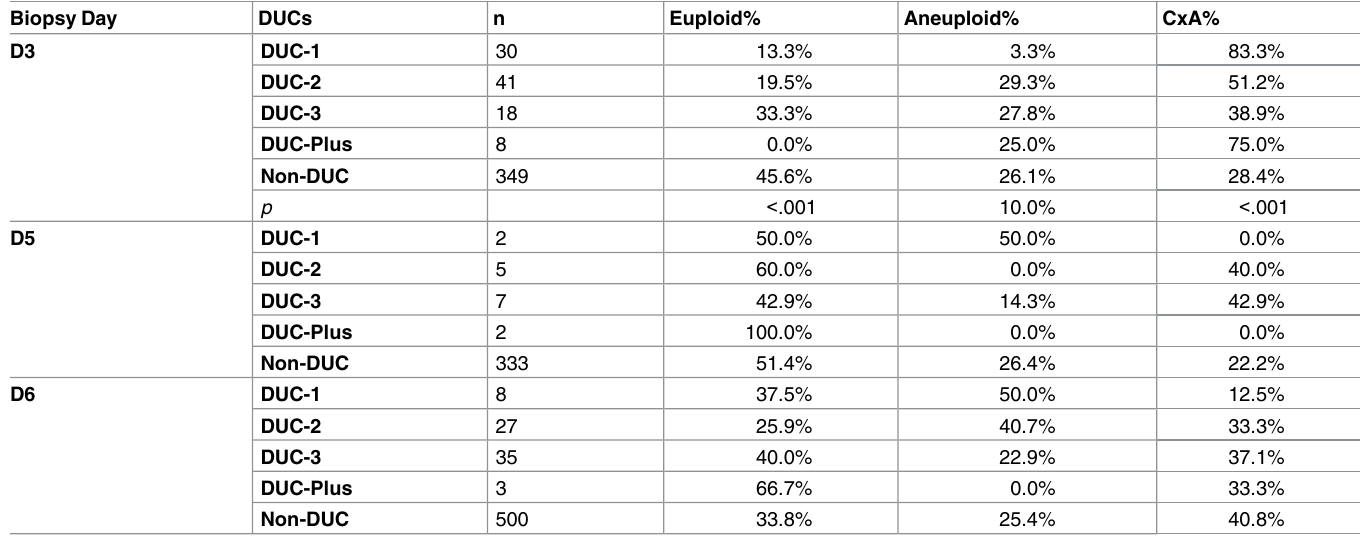
Table 4. Summaryof preimplantation genetic screen results in day 3/5/6 biopsied DUC embryos. Biopsy